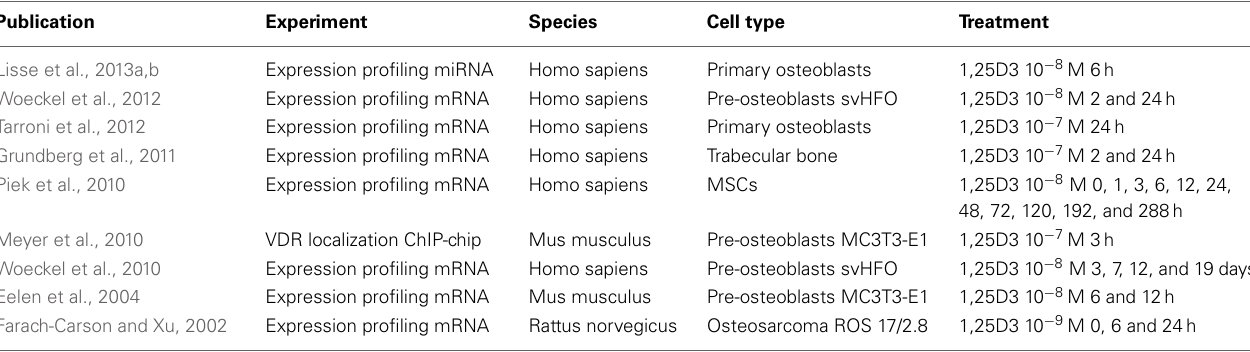
Table 1 | Genome-wide studies of vitamin D and